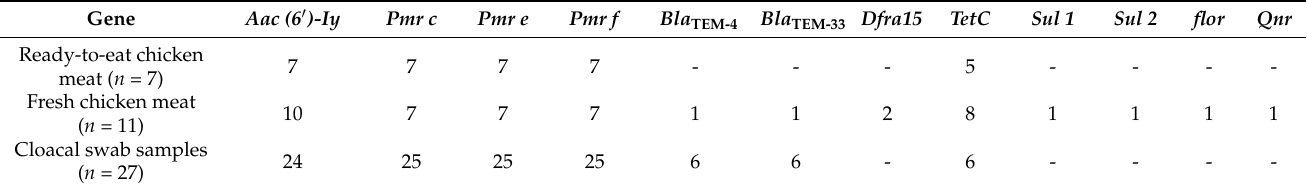
Table 3. Distribution of antimicrobial resistance AMR genes in Salmonella Enteritidis isolates based on the antimicrobial susceptibility test